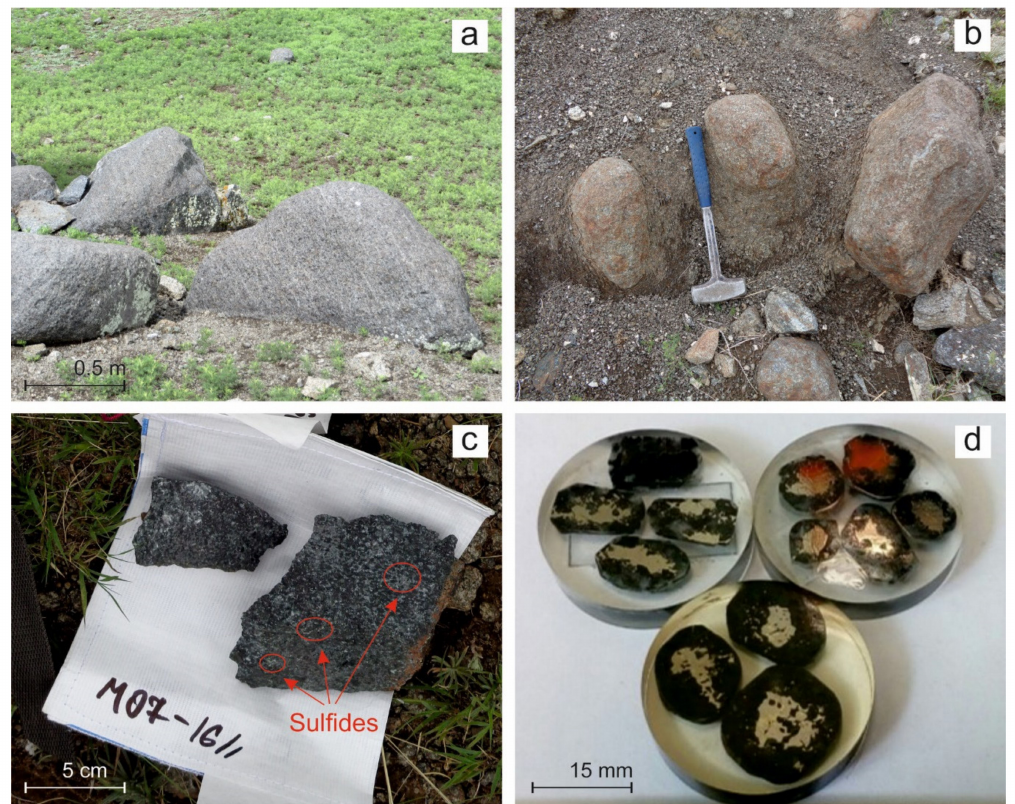
Figure 2. Photos of outcrops. ( a ) Layered gabbro of the Oortsog massif; ( b ) lumps of gabbro with oxidized sulfide droplets; ( c ) sample of Bt-Hbl-bearing mezogabbro with disseminated sulfides; ( d ) the preparation with sulfides droplets mounted in epoxy resin and polished.